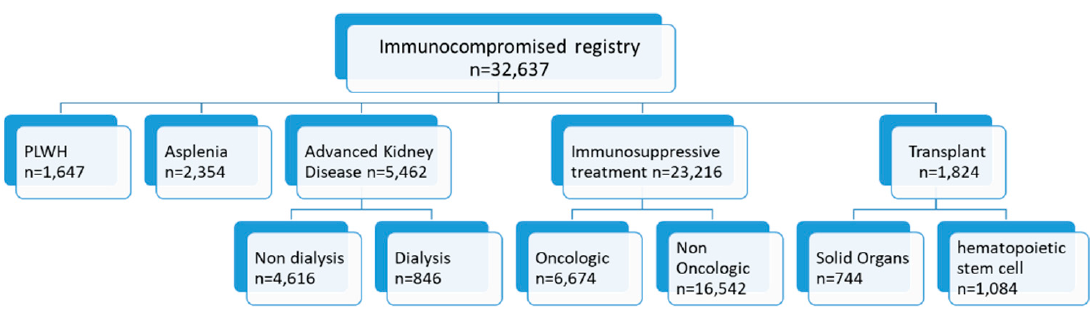
Figure 1. Immune-compromised patients registry structure and population, Israel, October 2019.